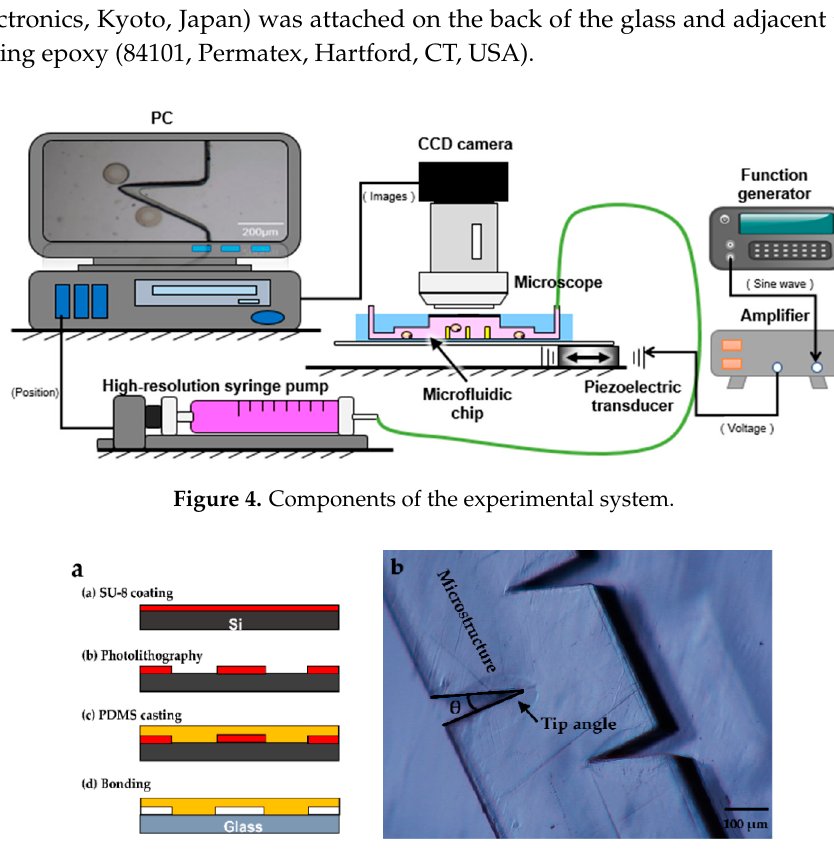
Figure 5. Microfluidic chip fabrication: ( a ) fabrication process of the microfluidic chip and ( b ) digital microscopic image of the solid microstructure mold ( θ = 20°).